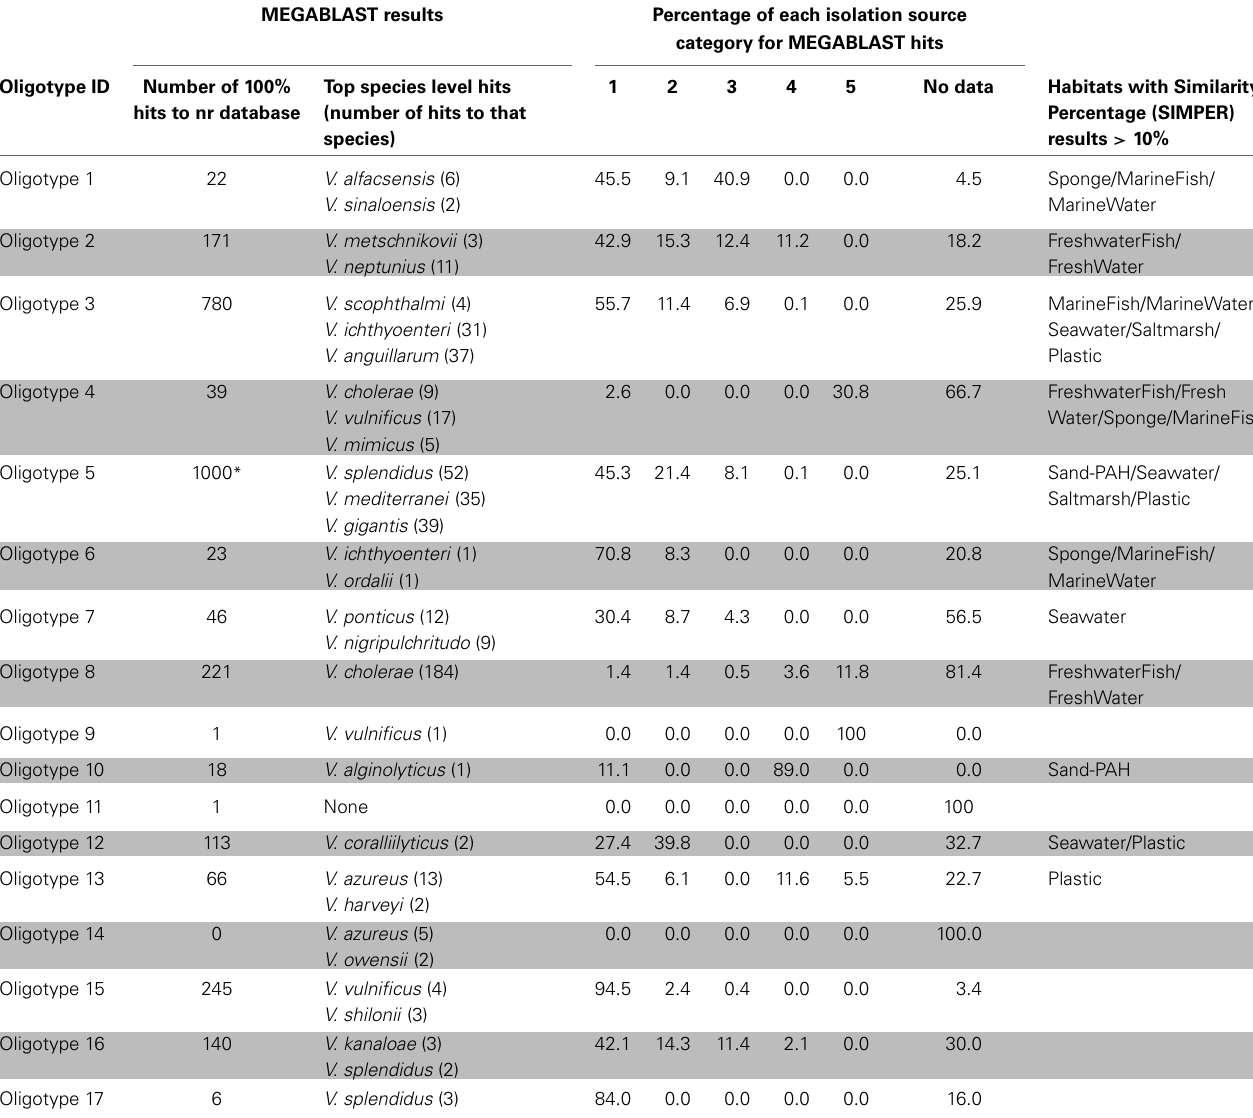
Table 3 | Summary of the 10 most abundant oligotypes from each of three oligotyping analysis groupings. MEGABLAST results Percentage of each isolation source category for MEGABLAST hits